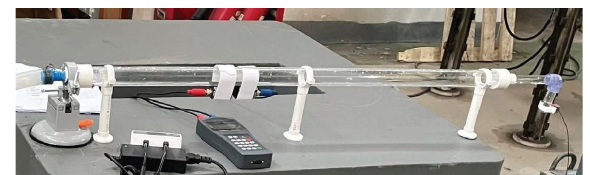
Figure 21: Diagram of the experimental